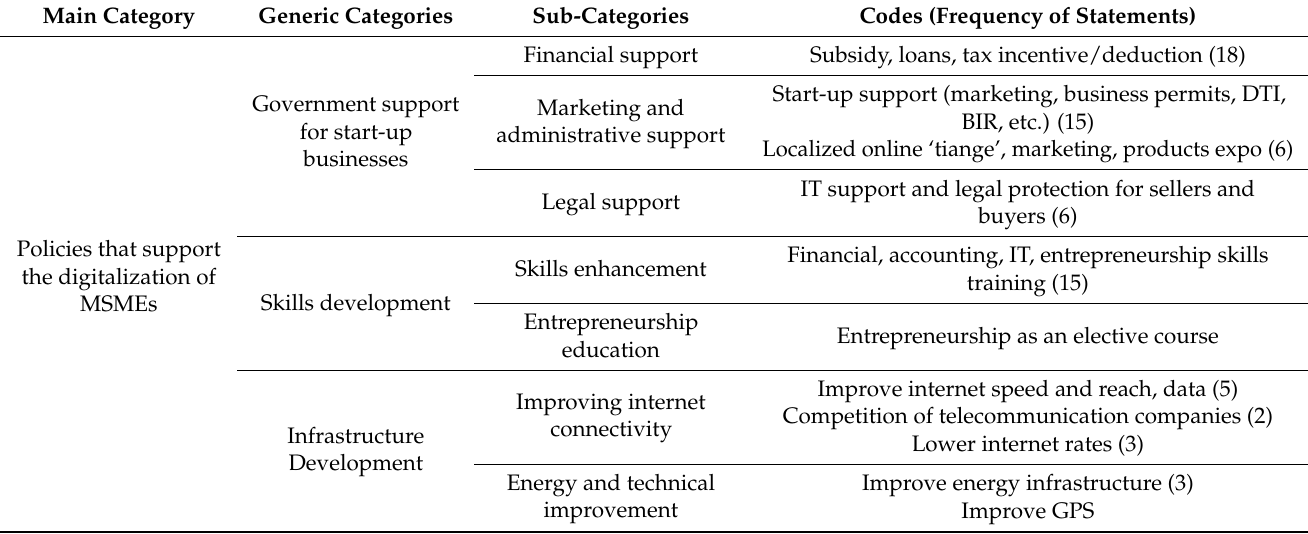
Table 3. Abstraction results of young entrepreneurs’ recommended policy to support the digitaliza- tion of MSMEs (see Appendix B Table A2 for the Summary of Generated Codes and the Significant